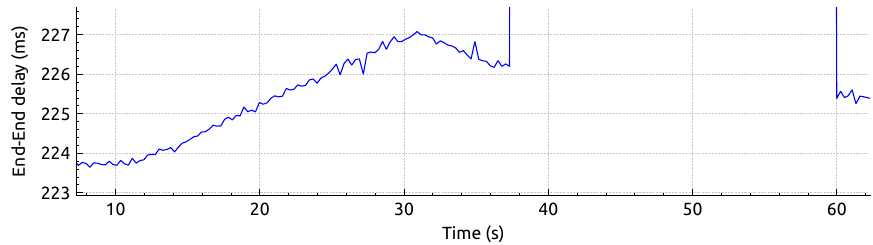
Figure 4. End to end delay measured with the model of an acoustic